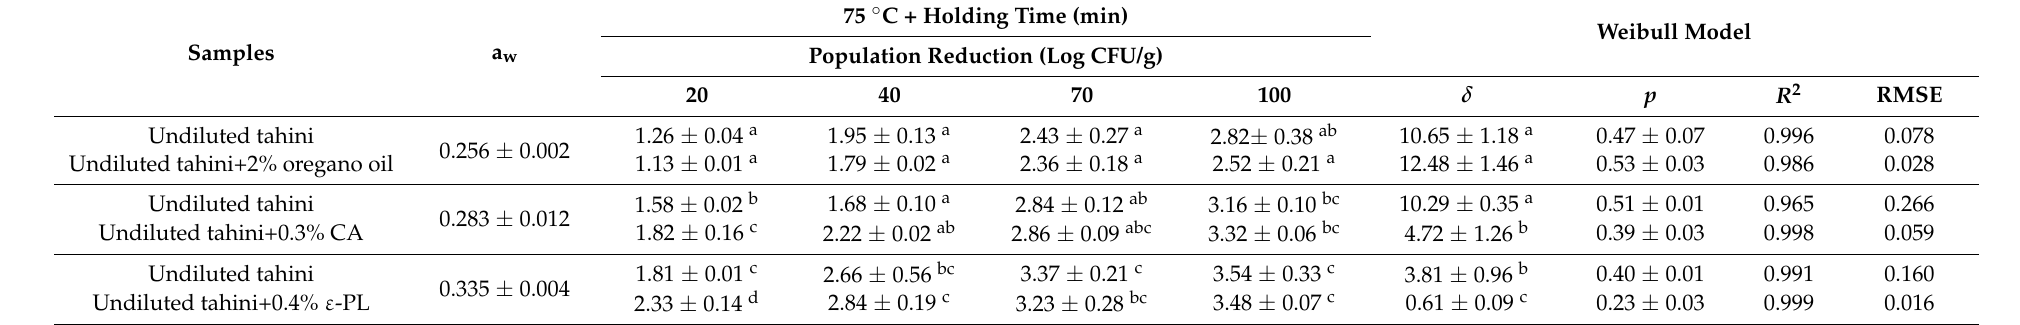
Table 6. Synergistic effects of thermal inactivation in combination with antimicrobials against S. montevideo CICC21588 inoculated into undiluted